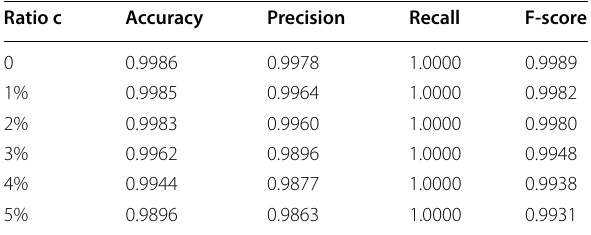
Table 6 Response of the model in this paper with dirty data